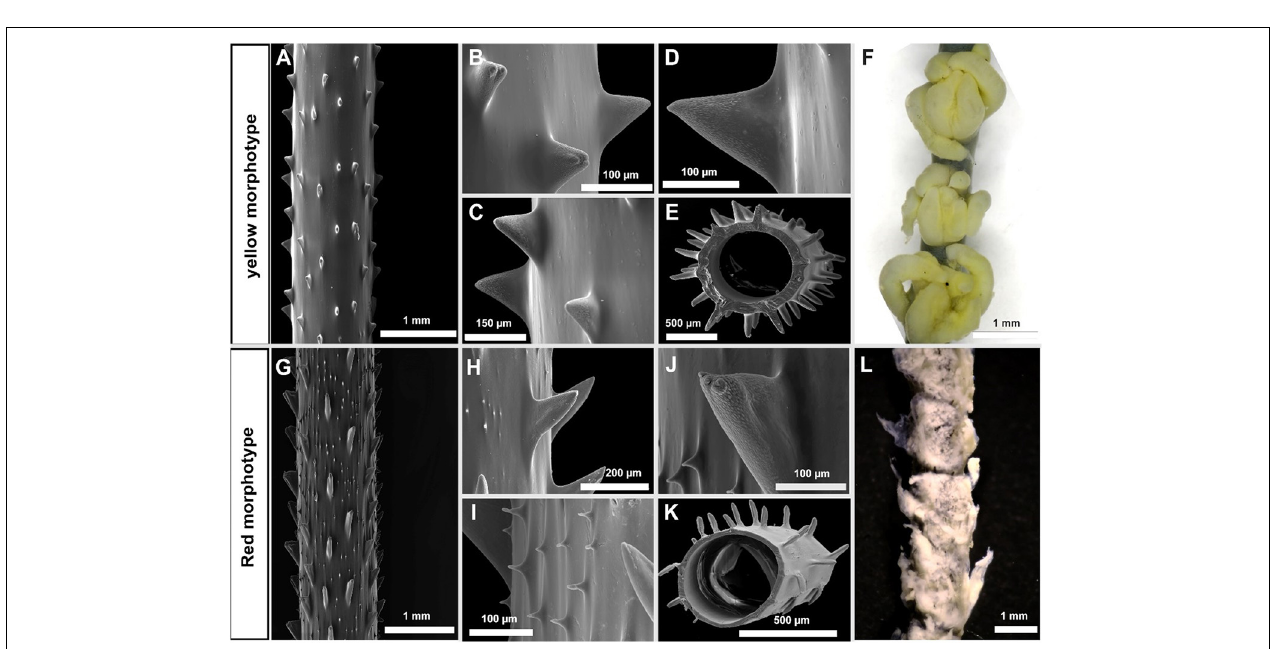
FIGURE 3 | Morphological characteristics of stem, spines, and polyps in the yellow morphotype ( Stichopathes sp. SCBUCN-8849) (A–F) and red morphotype ( Stichopathes sp. SCBUCN-8850) (G–L) . (A,G) Skeletal spines on terminal branch; (B,C,H,I) close-up view of the stem; (D,J) close-up view of polypar spine; (E,K) diameter of the central canal; (F) polyps on terminal branch under light microscopy; (L) polyps in poor condition under light microscopy.